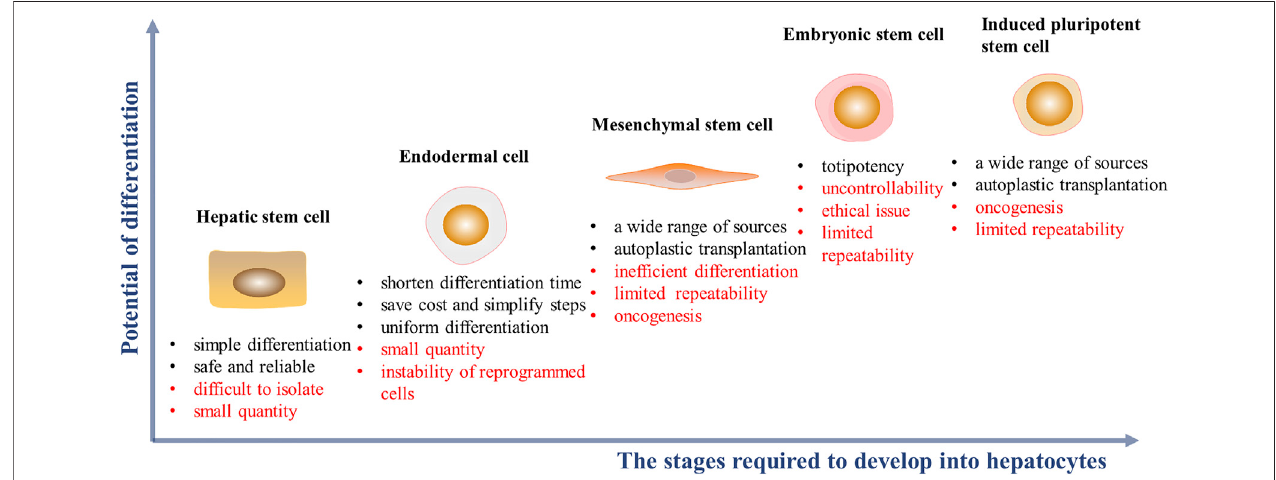
FIGURE 2 | Cell sources of HLCs induction in vitro and their advantages (black font) and disadvantages (red font). The abscissa represents the complexity of the stages required during hepatic differentitation. The ordinate represents the potential of cell differentiation into other cell types.